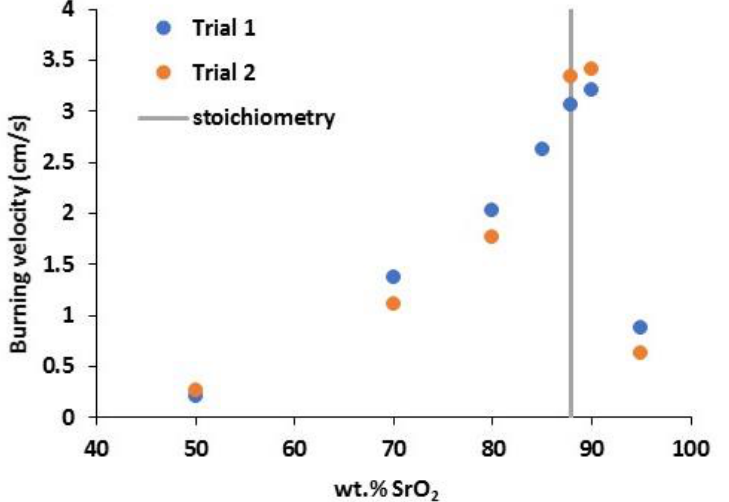
Figure 3. Measured burning velocities of binary SrO 2 /DNAN compositions as functions of oxidiser content.